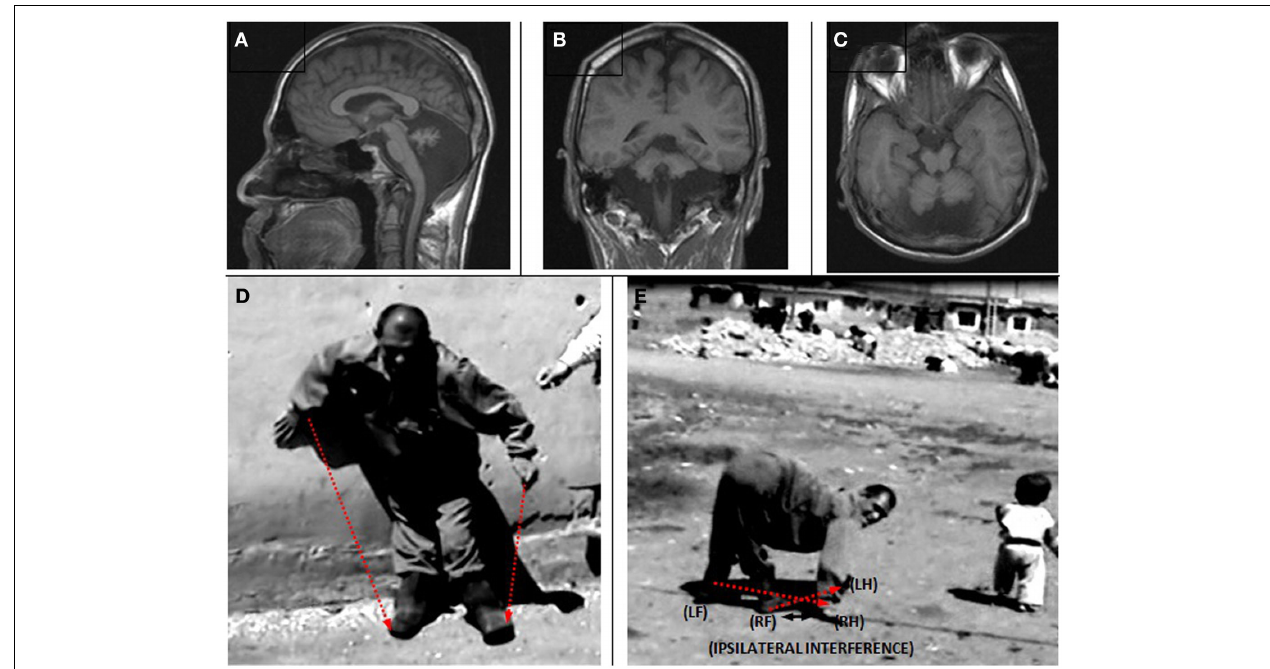
FIGURE 5 | Case IV-22. Sagittal (A), coronal (B) and axial (C) MRI scans. (D) Releasing from the wall to make a step: notice the parallel action of the left arm and left leg; (E) diagonal-sequence QL soon after releasing from the wall: notice the interference between the right arm and right leg.